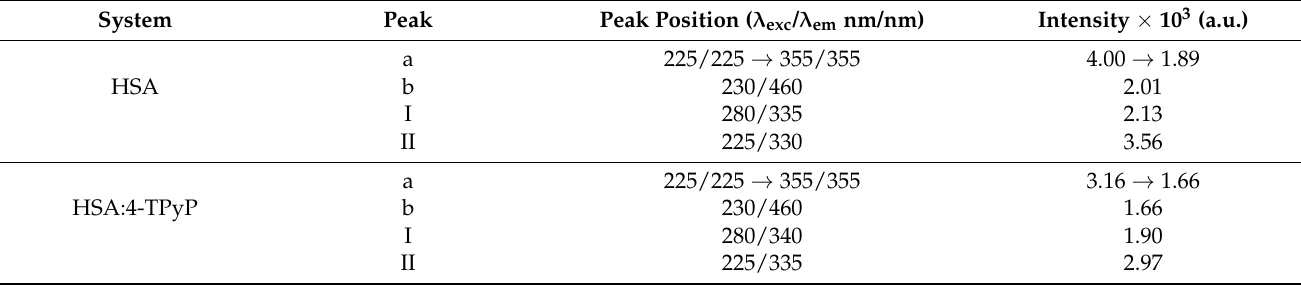
Table 2. The 3D-fluorescence spectral characteristics for HSA and HSA:4-TPyP in pH = 7.4 at room